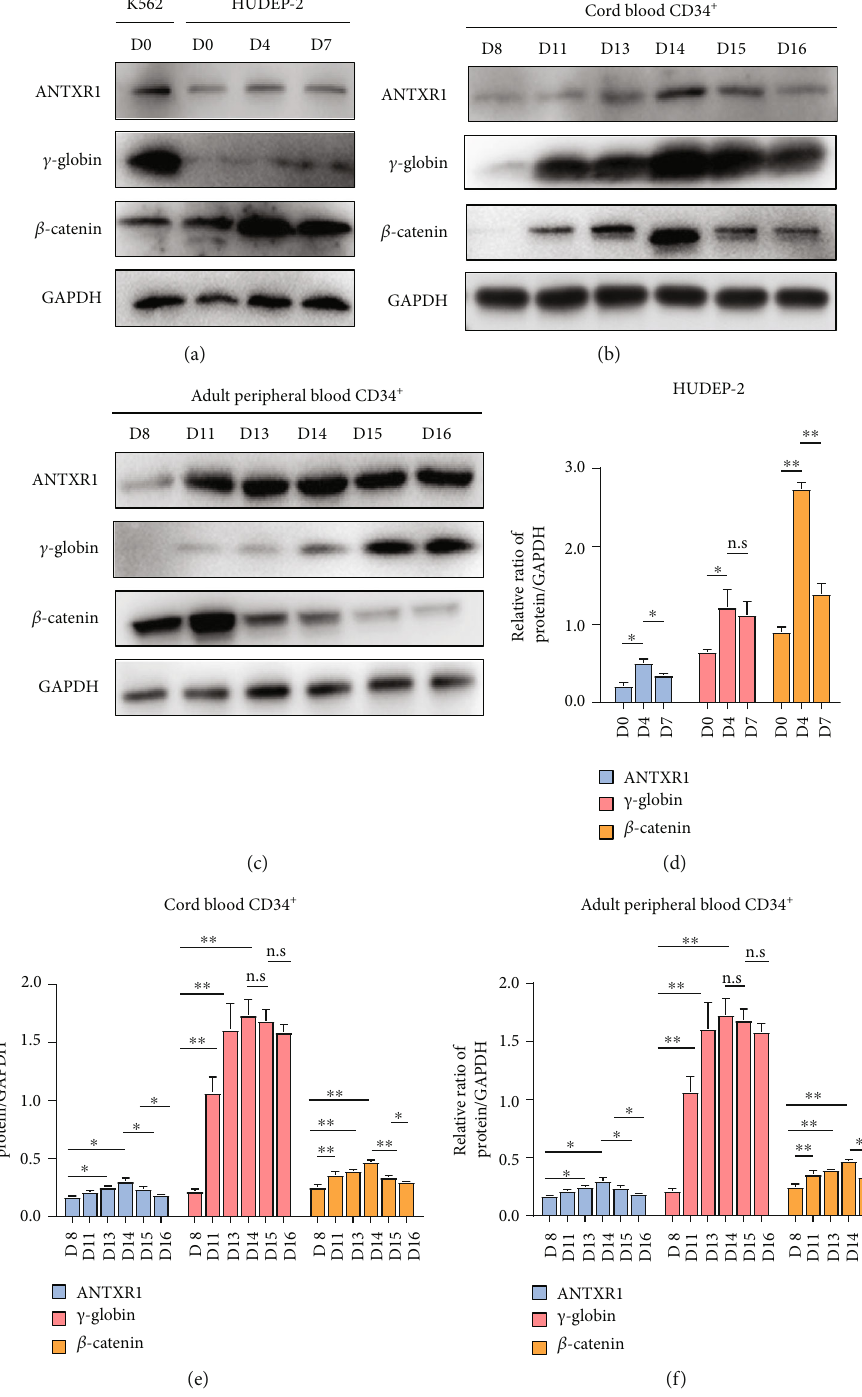
Figure 1: Expression of ANTXR1, γ -globin, and β -catenin during erythroid di ff erentiation. (a) Western blot analysis was performed to detect the expression levels of ANTXR1, γ -globin, and β -catenin in K562 cells and HUDEP-2 cells at days 0, 4, and 7 of erythroid di ff erentiation. (b) Western blot analysis for the expression of ANTXR1, γ -globin, and β -catenin in umbilical cord blood CD34 + cells during erythroid di ff erentiation at days 8, 11, 13, 14, 15, and 16. (c) Western blot analysis for the expression of ANTXR1, γ -globin, and β -catenin in adult peripheral blood CD34 + cells during erythroid di ff erentiation at days 8, 11, 13, 14, 15, and 16. (d) Protein quanti fi cation of the western blot in HUDEP-2 cells ANTXR1, γ -globin, and β -catenin at days 0, 4, and 7. (e) Quanti fi cation of western blot results of ANTXR1, γ -globin, and β -catenin in umbilical cord blood CD34 + cells at days 8, 11, 13, 14, 15, and 16. (f) Quanti fi cation of western blot results of ANTXR1, γ -globin, and β -catenin in adult peripheral blood CD34 + cells at days 8, 11, 13, 14, 15, and 16. These experiments n = 3 . The error bar represents the SD. ∗ P < 0 : 05 and ∗∗ P < 0 : 01